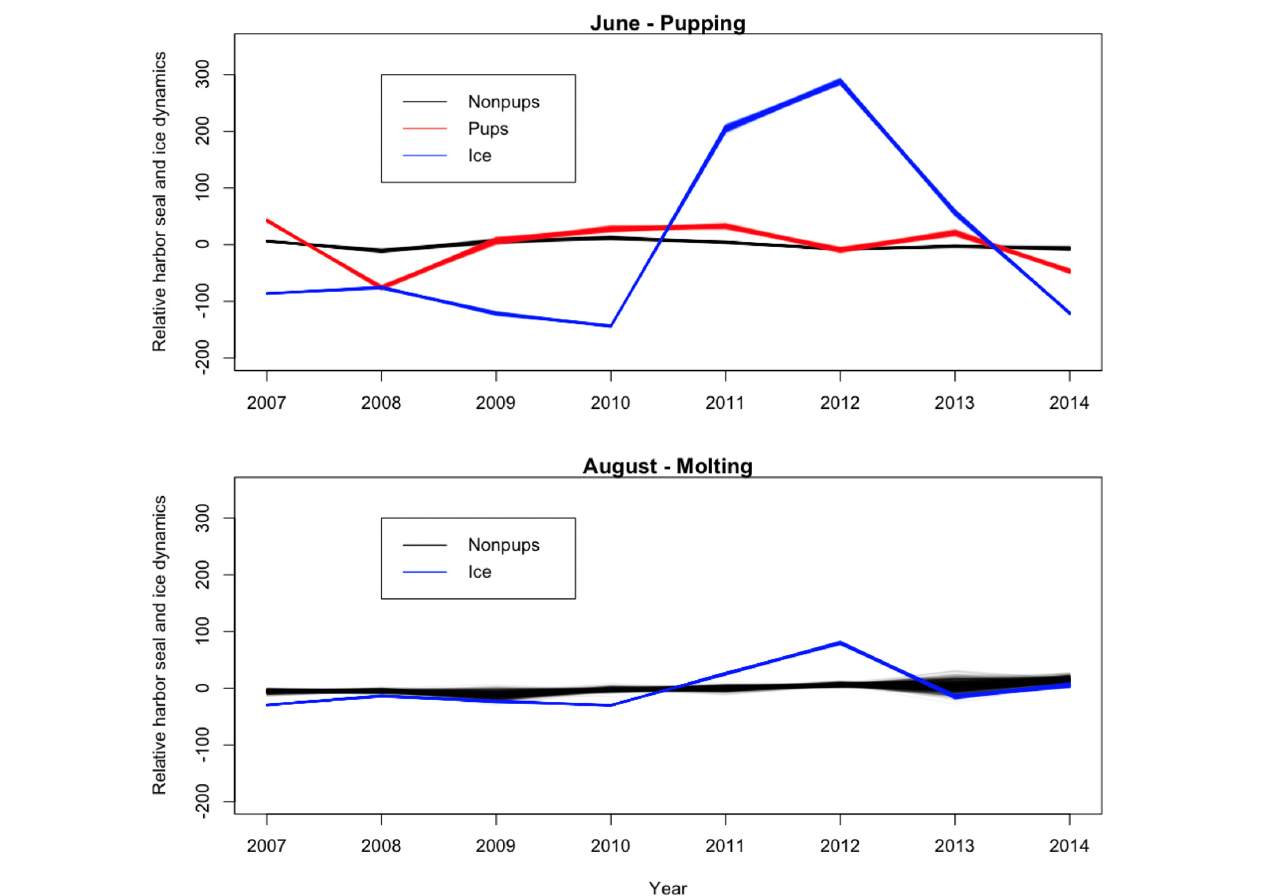
FIGURE 4 | Time series plot (averaged over space) of the relative abundance of harbor seal non-pups, harbor seal pups, and the proportion of ice, including icebergs and brash ice, from 2007 to 2014 in Johns Hopkins Inlet in Glacier Bay National Park in southeastern Alaska. Units on the y -axis are the expected value of the response variables, which are scaled, summed over space and centered to have a mean